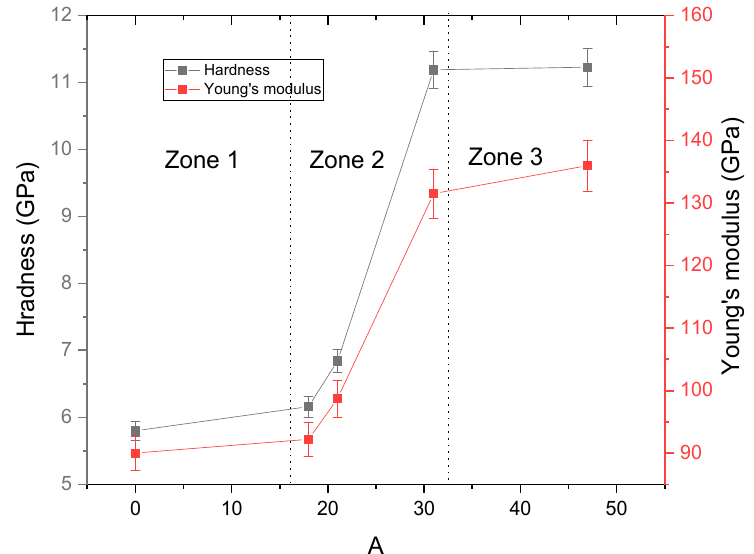
Figure 6. Evolution of Young’s modulus and hardness as a function of tantalum content.